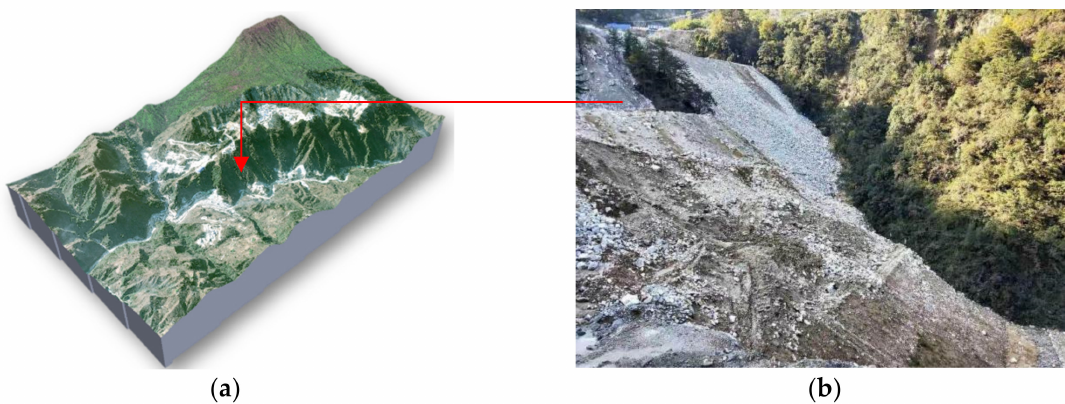
Figure 10. Original topography and current situation of the rockfill slope: ( a ) The topography where the rockfill slope is located; ( b ) Construction status.